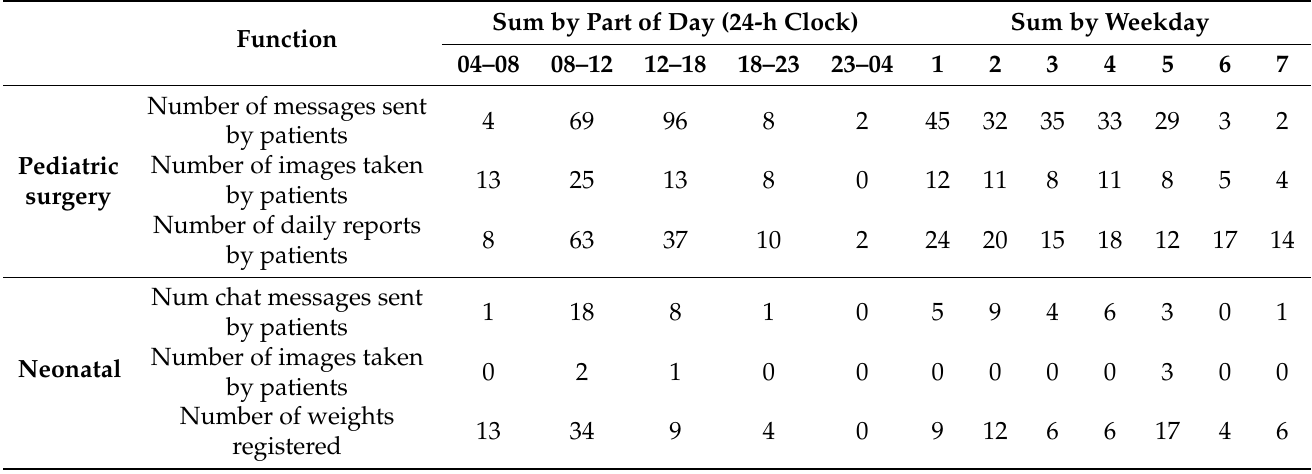
Table 3. The distribution of eHealth device usage over 24 h and weekdays (Monday is denoted 1), including data obtained from 18 eHealth devices provided to 18 families, whereof 9 from pediatric surgery and 9 from neonatal care. The eHealth devices were used during median 2.5 (2–5) weeks.